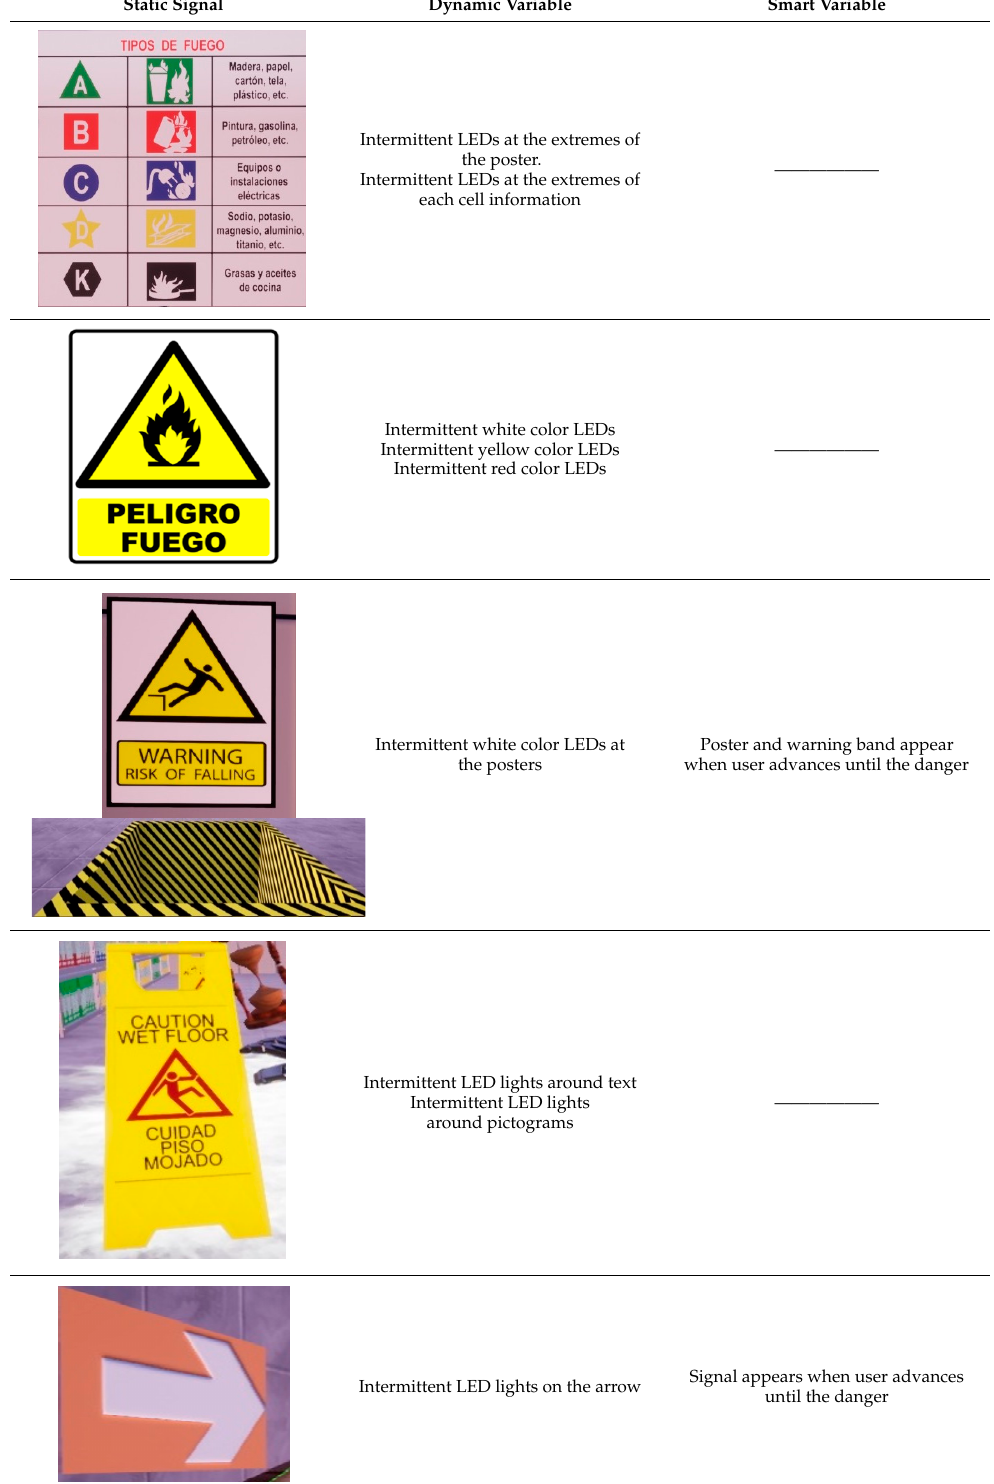
Table 2. Signals used in Game for Safety.